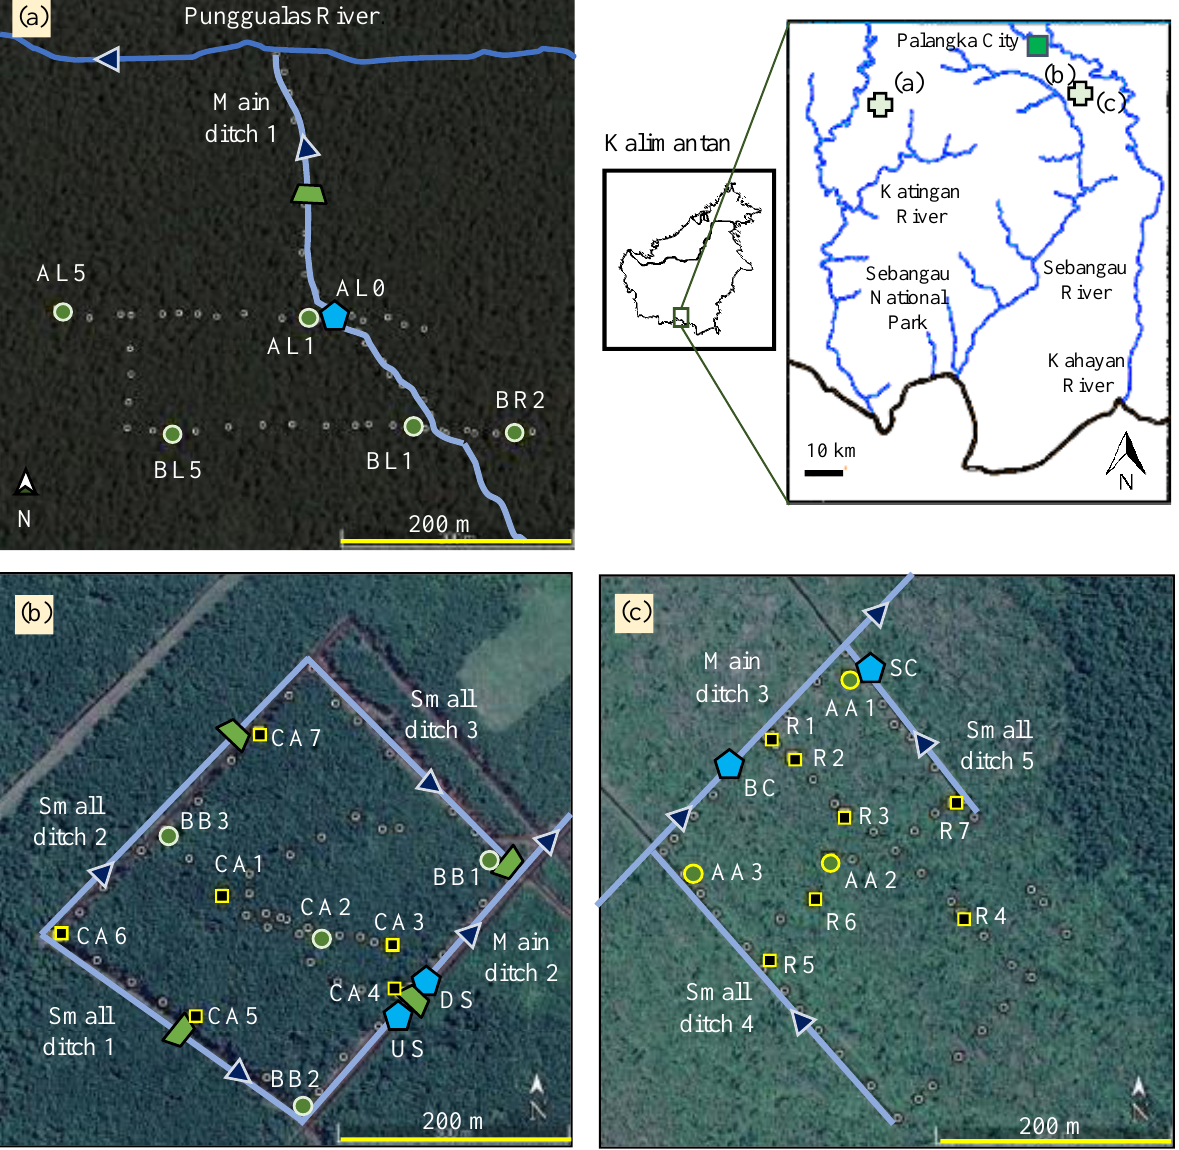
Figure 1. Schematic overview of the study sites, which were Forested (a), Blocked (b) and Drained (c). In the top right map the green square shows the location of Palangka City, and the plus signs are the study site locations. In (a) to (c), larger circles symbolise logger wells, smaller circles are levelling points, squares are testing points, blue pentagons are ditch loggers, and trapezoids are dams. The dark blue continuous line represents a river and the light blue lines are ditches. The main flow directions are shown by arrows. Peat cores were taken at AA1, AA2, AA3, BB1, BB2, BB3, AL0, AL1 and AL5. Surface hydraulic conductivity tests ( K ) in Drained and Blocked were conducted at all logger wells, all points with label CA, and all points with label R. Surface K tests in Forested were conducted at Wells AL1 and AL5